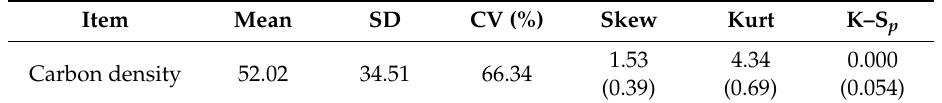
Table 3. Descriptive statistics of vegetation carbon density (including tree, understory vegetation and litter layers) in Pinus massoniana forest (Mg·ha − 1 ).